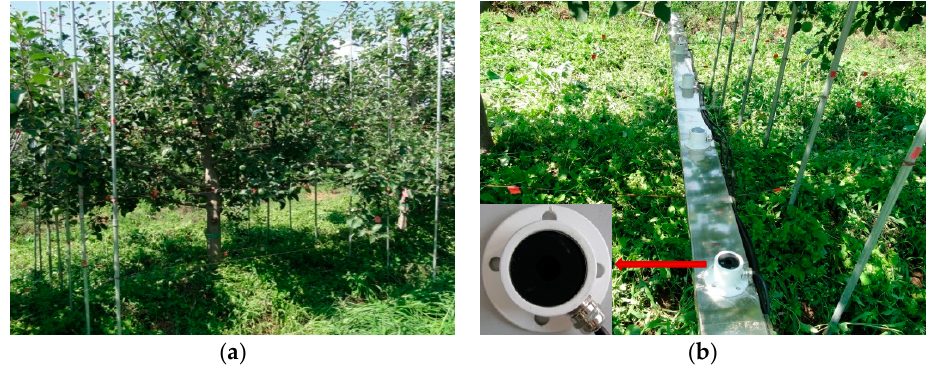
Figure 3. Canopy division of an apple tree canopy and light intensity measurement. ( a ) Canopy division; ( b ) Light intensity measurement.